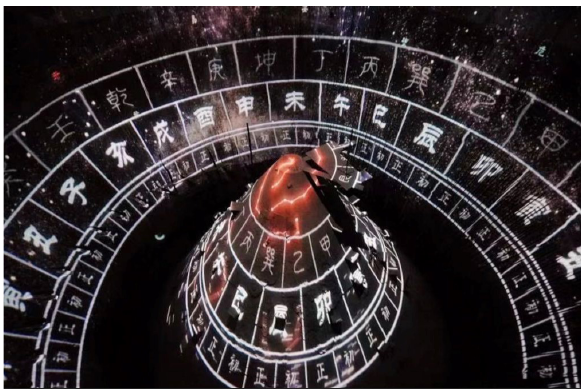
Figure 3. RE - International Center for Digital Creativity 1-2 .